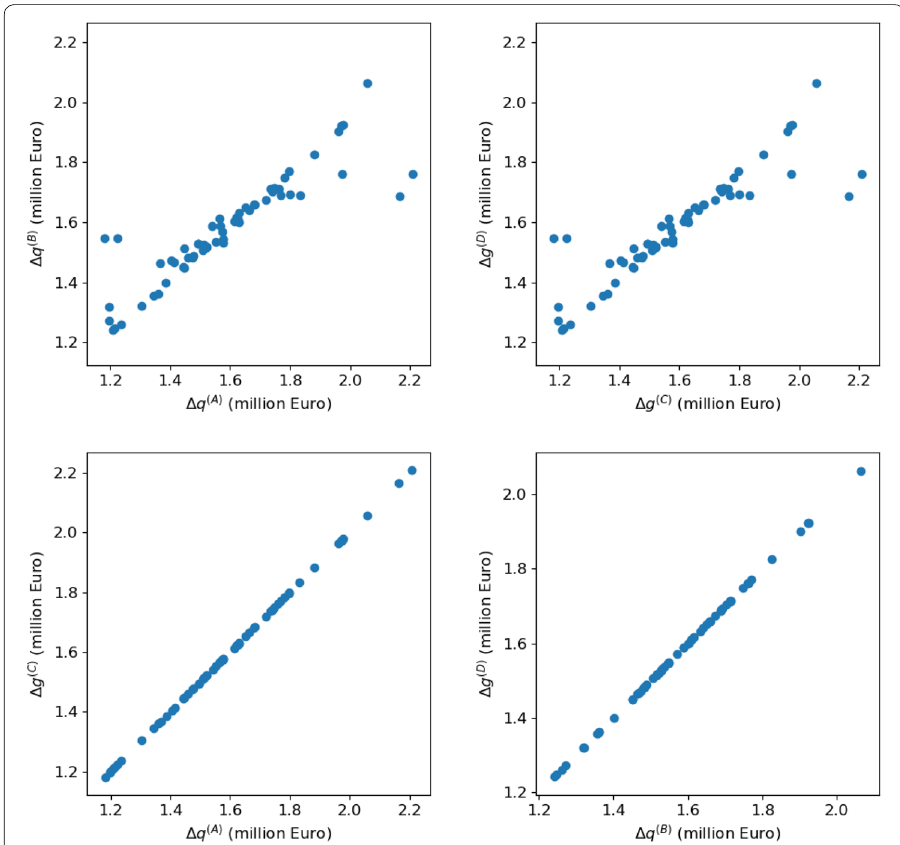
Fig. 4 Scatterplots of the change in output levels ( (cid:31) q for the product-by-product tables and (cid:31) g for the industry-by-industry tables) using the four models A–D. Each dot represents the change in output level when demand for that output is increased by 1 million